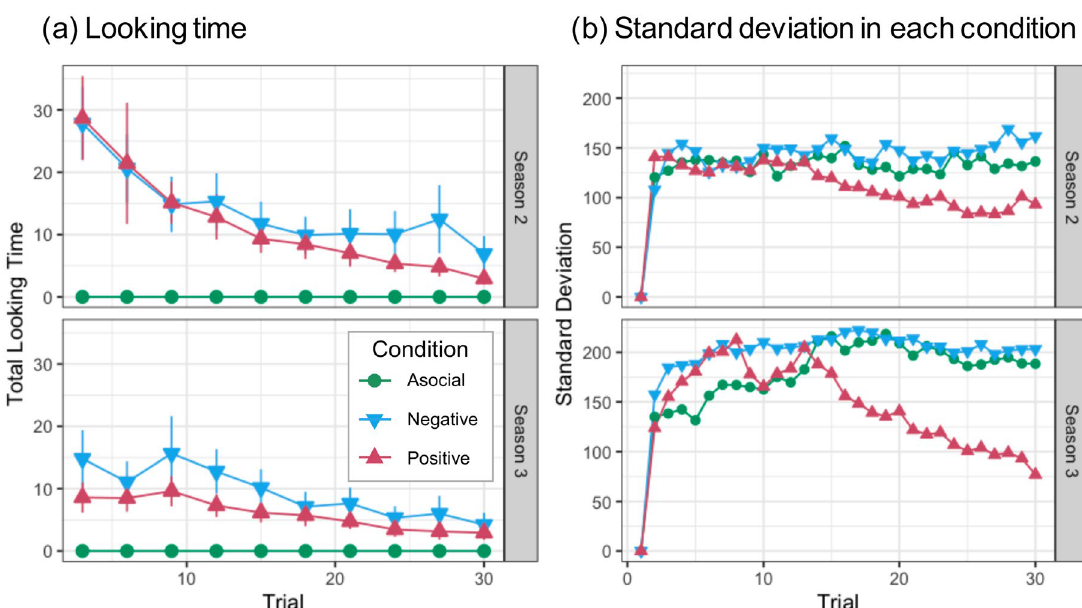
Figure 3. ( a ) Average total looking time (seconds) of social information. Error bars represent standard errors. ( b ) Standard deviation in fitness against